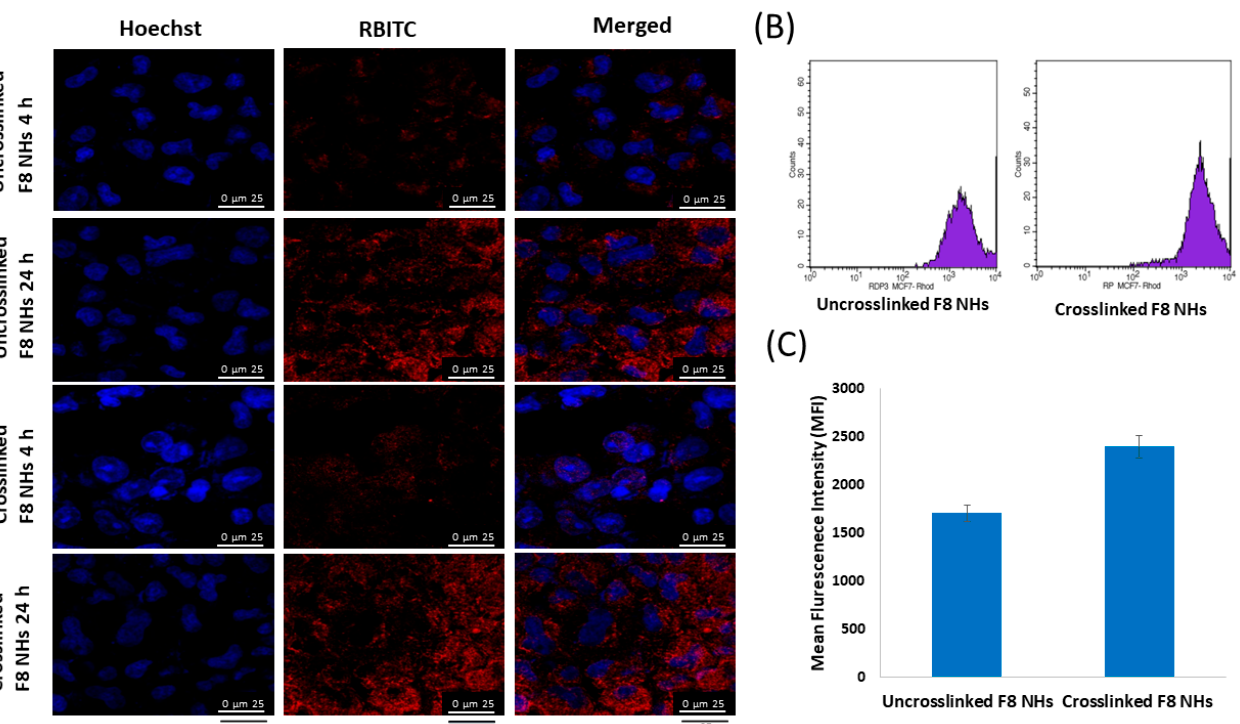
Figure 7. ( A ) Confocal images revealing the uptake of uncrosslinked and crosslinked PMT– ALG/LF–RST NHs F8 after incubation for 4 h and 24 h; scale bars 25 μ m; ( B ) histogram profiles of flow cytometry of MCF-7 cells after incubation for 4 h; ( C ) estimation of the mean fluorescence in- tensity level in MCF-7 cells after incubation for 4 h with RBITC-labeled uncrosslinked and cross- linked PMT–ALG/LF–RST NHs F8 ( n =